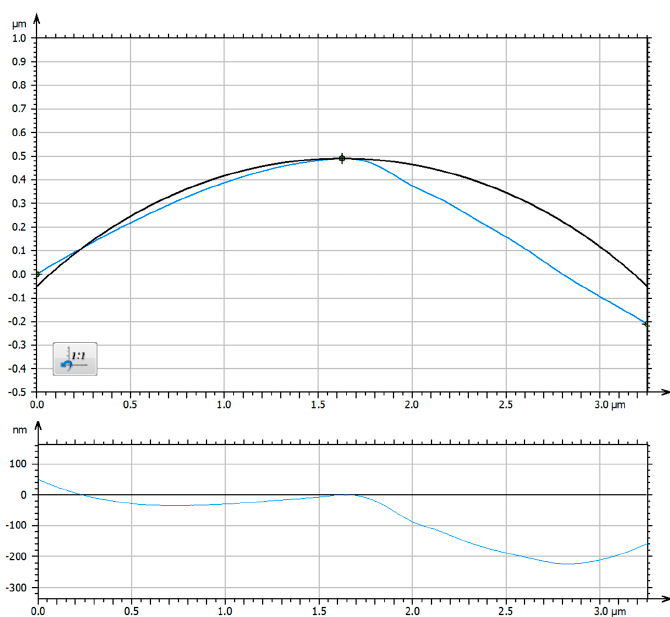
Figure 32. The upper graphical rendering illustrates the true surface profile at the spherical region in the blue line versus the ideal surface profile for a spherical tip with a 2.71 μ m radius in the black line. The figure compliments Figure 31b. The plot introduced at the bottom of this figure clearly captures the surface profile deviation from a circle of the 2.71 μ m nominal radius.